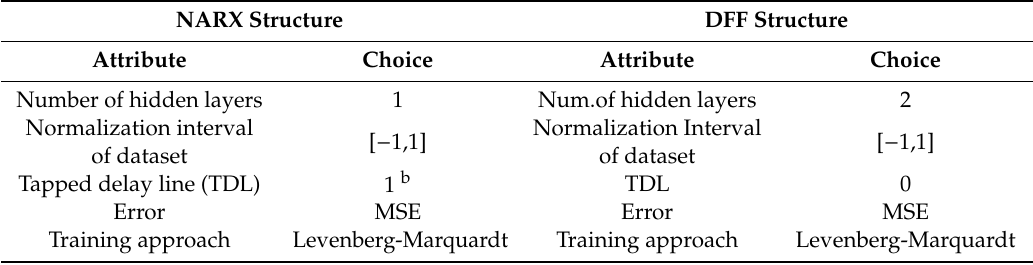
Table 3. Attributes of the proposed neural network model’sstructures. MSE: mean squared error.